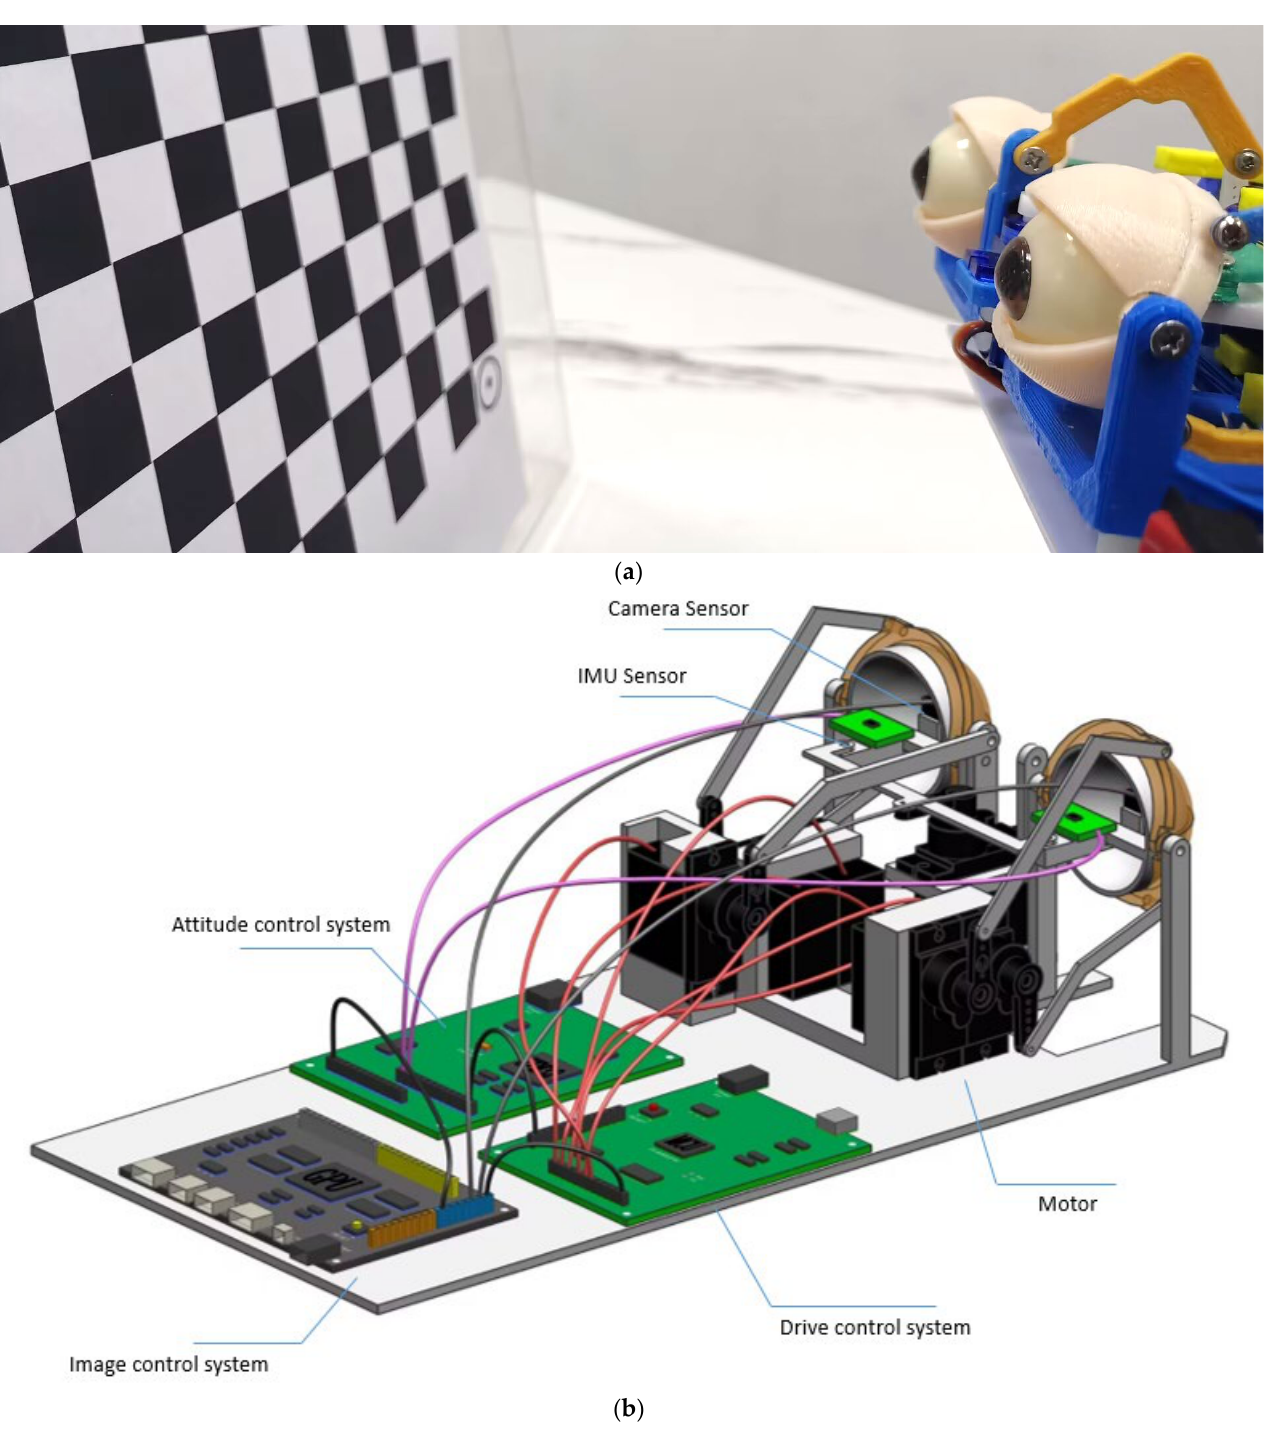
Figure 4. ( a ) is the experimental model of the bionic eye, and ( b ) is the structure of the bionic eye model.